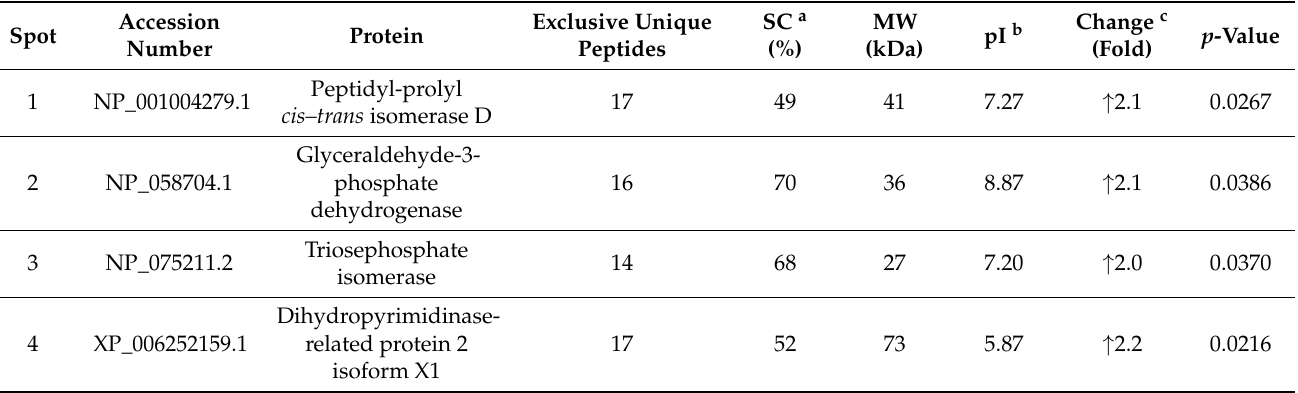
Table 3. LC–MS/MS analysis of altered protein spots in PNS fractions isolated from mPFC of SNL versus sham-operated rats 8 weeks after the surgery. The complete list of exclusive unique peptides is presented in Table S2.